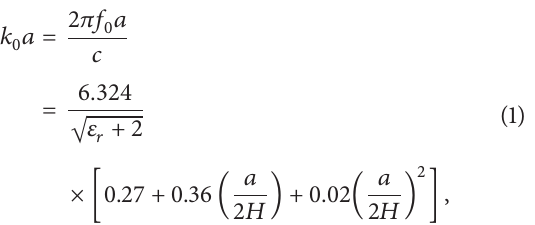
= 10 mm, 𝐿 = 11.68 mm, 𝑊 1 2 =13 𝜇 m. th